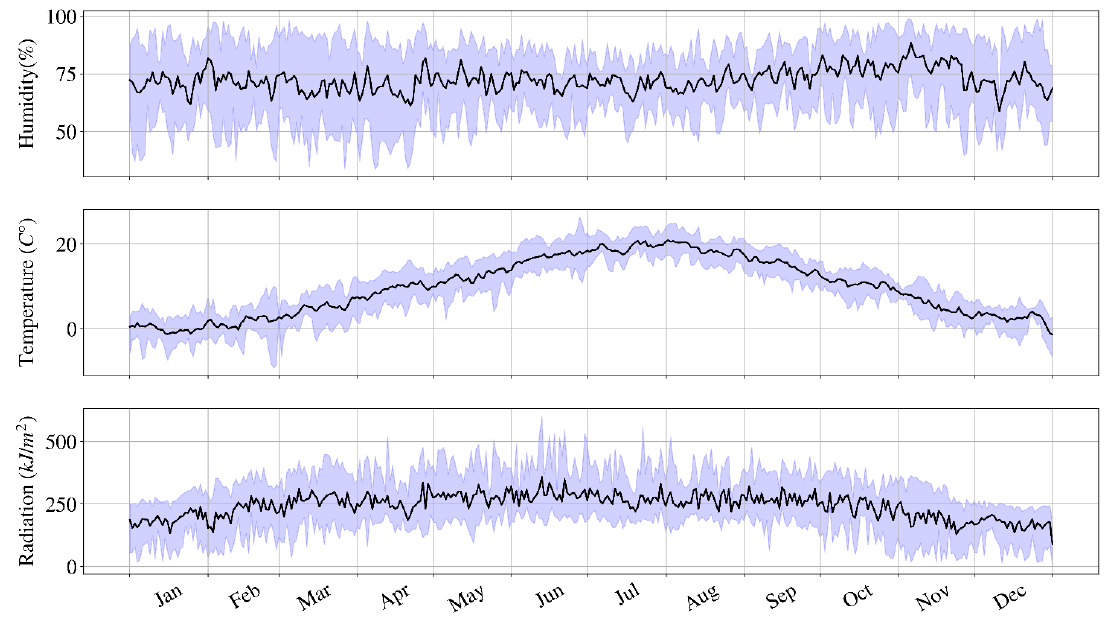
Figure 2. Meteorological ERA5 data from 2013 to 2020 for different variables. Black line depicts the daily average values, whereas the purple interval shows the minimum and maximum values for each day of the year. day of the